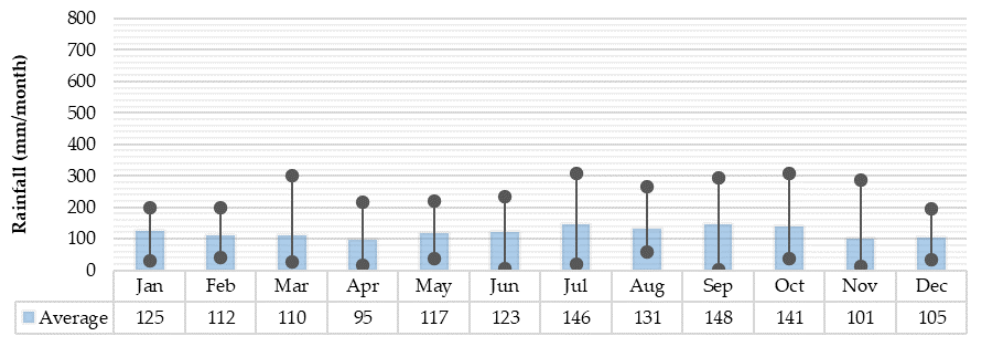
Figure 4. Average, minimum and maximum monthly rainfall in the city of Porto Alegre over 2003–2017.